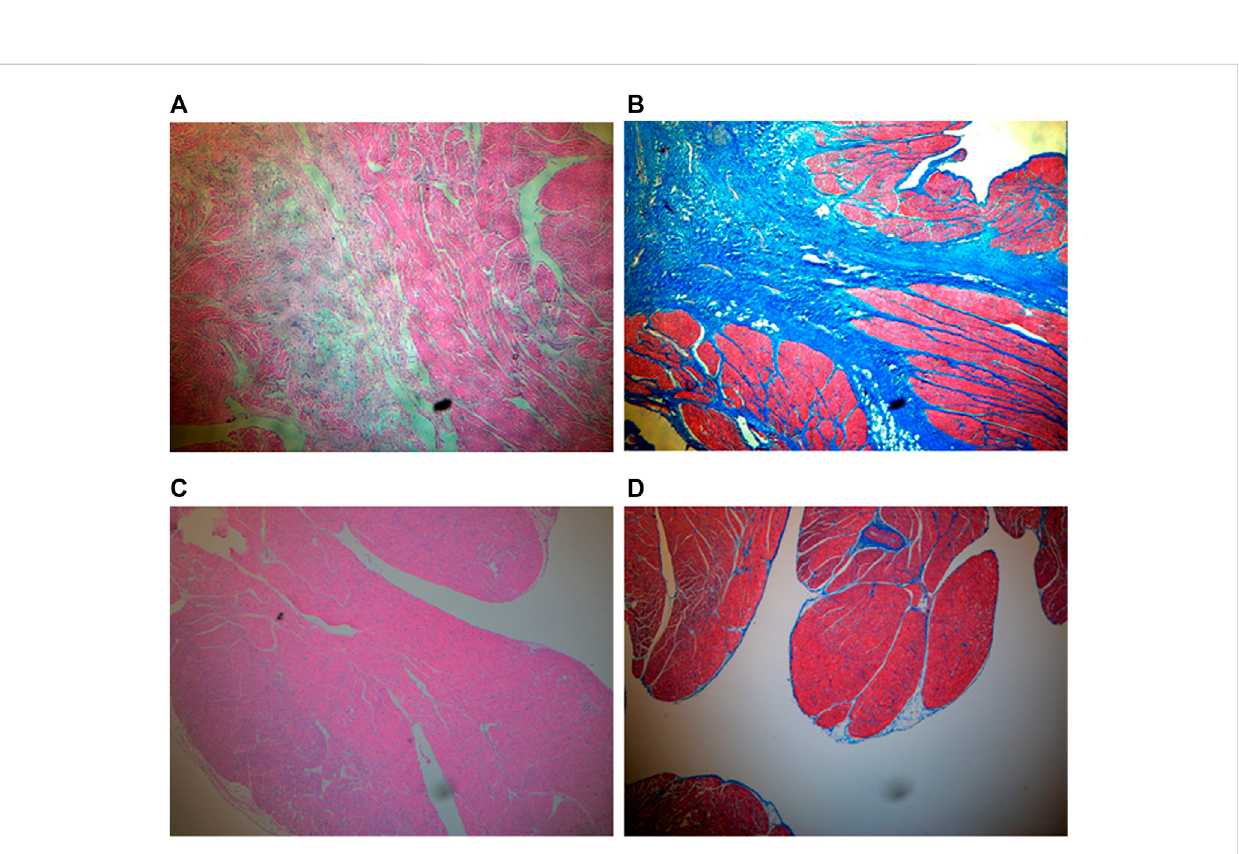
FIGURE 4 HE and MT staining (×4 objective). (A) HE for inverted LAA. Tissue remodeling and fi brosis are shown between myocardia. (B) MT for inverted LAA. Collagen expresses in blue, and myocardium expresses in red. (C) HE for right atrial appendage as control. (D) MT for right atrial appendage as control.